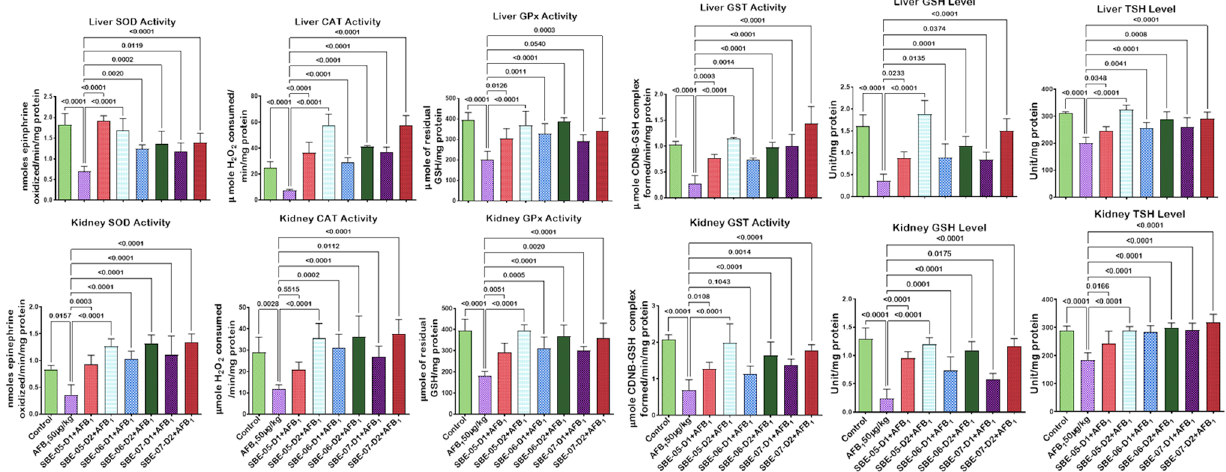
Figure 6. Effect of SBE-05, SBE-06 and SBE-07 on the tissue concentrations of CAT, SOD, GPx, GST, GSH and TSH in the liver and kidney of rats treated with AFB 1 for 28 d. Experimental doses: AFB 1 at 50 μg/kg; SBE- 05-D1 at 5 mg/kg; SBE-05-D2 at 10 mg/kg; SBE-06-D1 at 5 mg/kg; SBE-06-D2 at 10 mg/kg; SBE-07-D1 at 5 mg/ kg; SBE-07-D2 at 10 mg/kg. Values are expressed as mean ± SD for 6 rats per treatment cohorts. Connecting lines indicate groups compared to one another, the significance level was set at (p < 0.05) ; * p < 0.05; ** p < 0.01; *** p < 0.001; **** p < 0.0001: indicates the level of significance; p > 0.05: not significant. AFB 1 Aflatoxin B1; D1